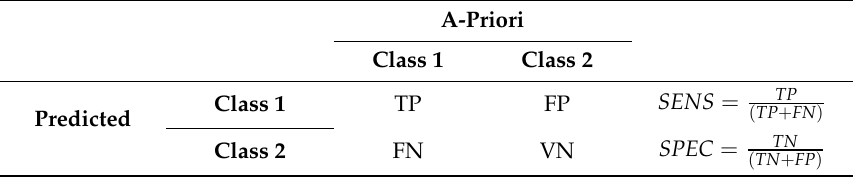
Table 3. Generic confusion matrix identifying true positive (TP), false positive (FP), true negative (TN), false negative (FN), and the reference equation to calculate sensitivity (SENS) and specificity